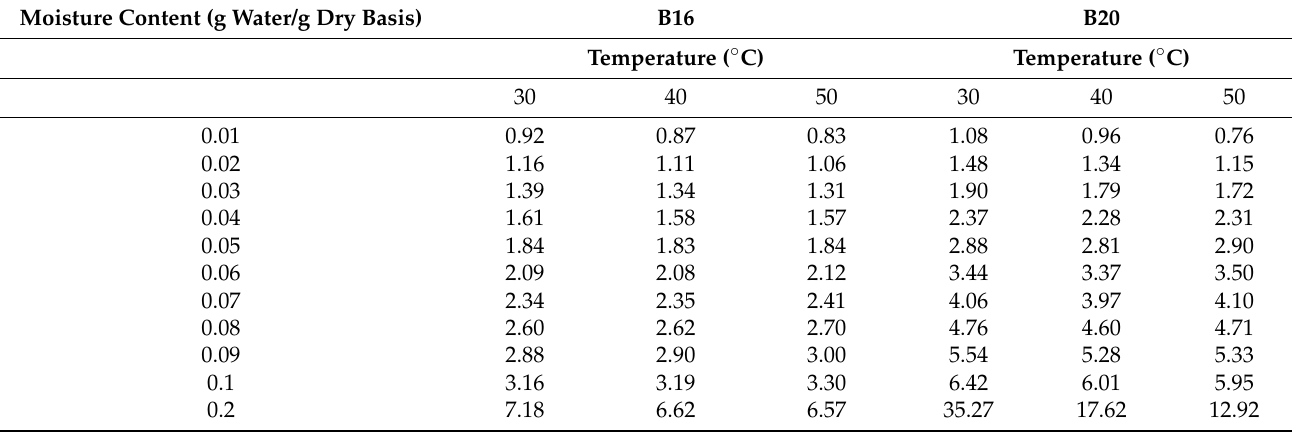
Table 2. Pore radius (nm) of B16 and B20 at temperatures of 30, 40, 50 ◦ C and moisture content ranging from 0.01 to 0.2 g · water/g dry basis